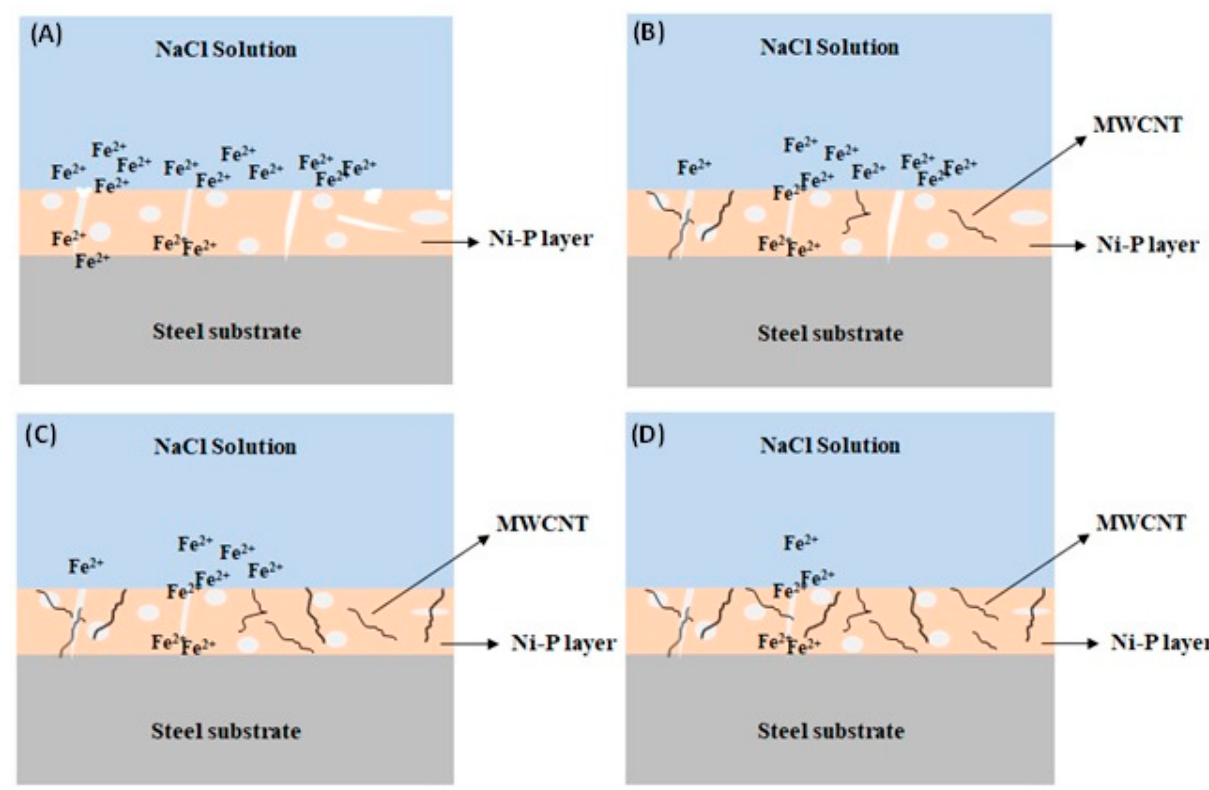
Figure 8. Schematic illustration of the corrosion mechanism of the Ni–P and Ni–P/MWCNT coatings: ( A ) Ni–P layer; ( B ) CNT-0.25; ( C ) CNT-0.50; ( D ) CNT-1.0.